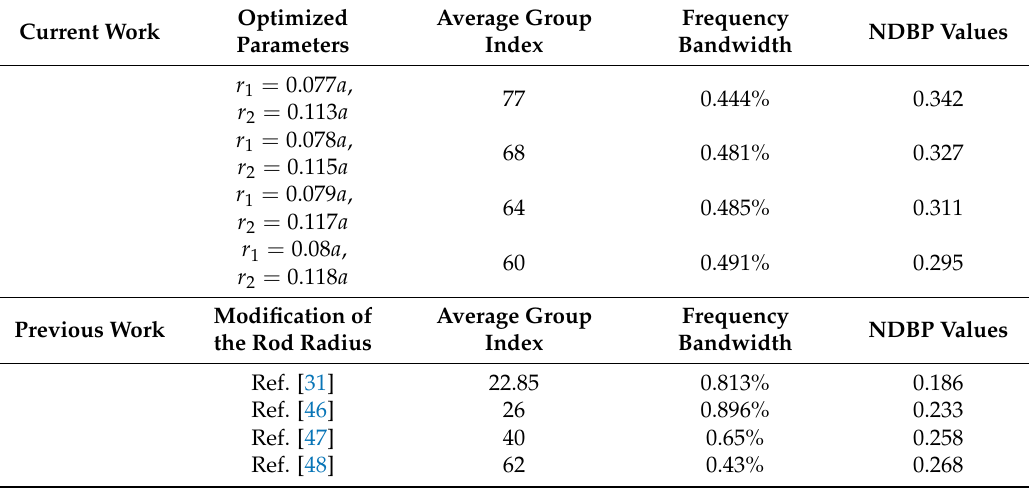
Figure 6. ( a ) Normalized delay-bandwidth product (NDBP) values of the four optimized PCWs as a function of the externally applied magnetic field 𝐻 0 ; ( b ) The 𝛽 2 as a function of the frequencies for the four optimized PCWs in Figure 5 with different 𝐻 0 . Table 1. Group index, frequency bandwidth, and NDBP values under different optimized parameters and the comparison with previous works.